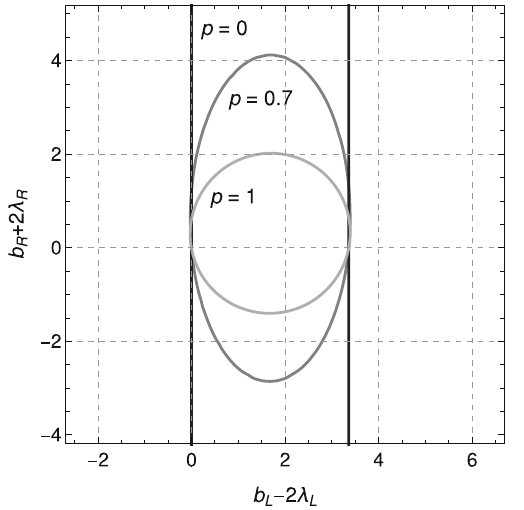
Fig. 13 The 95% C.L. Z → b ¯ b allowed regions of the b and λ param- eters when g (cid:2)(cid:2) = 18. The allowed regions form closed elliptical bands; the darkest gray correspond to p = 0, the lightest to p = 1, with p = 0 . 7 in between. When p = 0, only parts of two parallel bands of an “infinite” ellipse can be seen